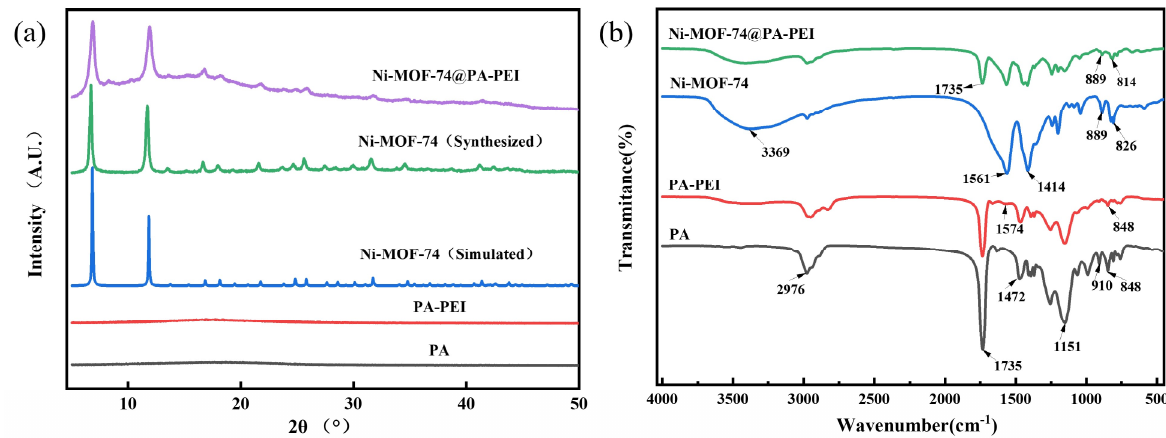
Figure 5. ( a ) X − ray diffraction patterns of PA, PA − PEI, Ni − MOF − 74 (simulated and synthesized), Figure 5. ( a ) X−ray diffraction paerns of PA, PA−PEI, Ni−MOF−74 (simulated and synthesized), and Ni − MOF − 74@PA − PEI. ( b ) Fourier − transform infrared spectra of PA, PA − PEI, Ni − MOF − 74, and Ni−MOF−74@PA−PEI. ( b ) Fourier−transform infrared spectra of PA, PA−PEI, Ni−MOF−74, and and Ni − MOF − 74@PA − PEI. Ni−MOF−74@PA−PEI. The Ni−MOF−74@PA−PEI composite material exhibited a uniform spherical shape